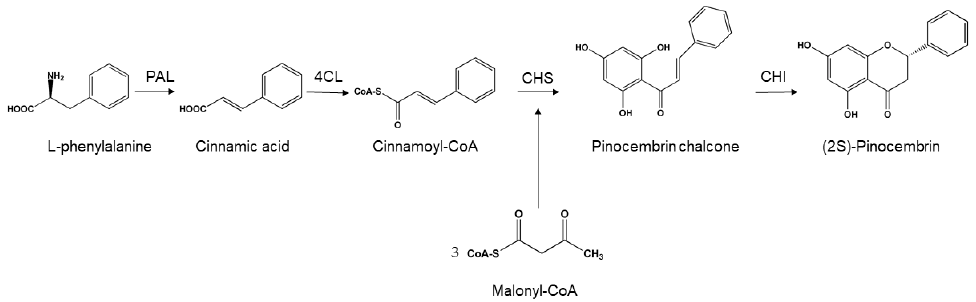
Figure 2. Classic biosynthetic pathway of pinocembrin [15]. L-Phenylalanine as a precursor compound produces cinnamic acid under the action of phenylalanine ammonia lyase, which generates cinnamoyl-CoA under the action of CoA ligase, and adds malonyl-CoA to the reaction system to form pinocembrin chalcone under the action of chalcone synthase. Finally, pinocembrin is generated under the action of chalcone isomerase.